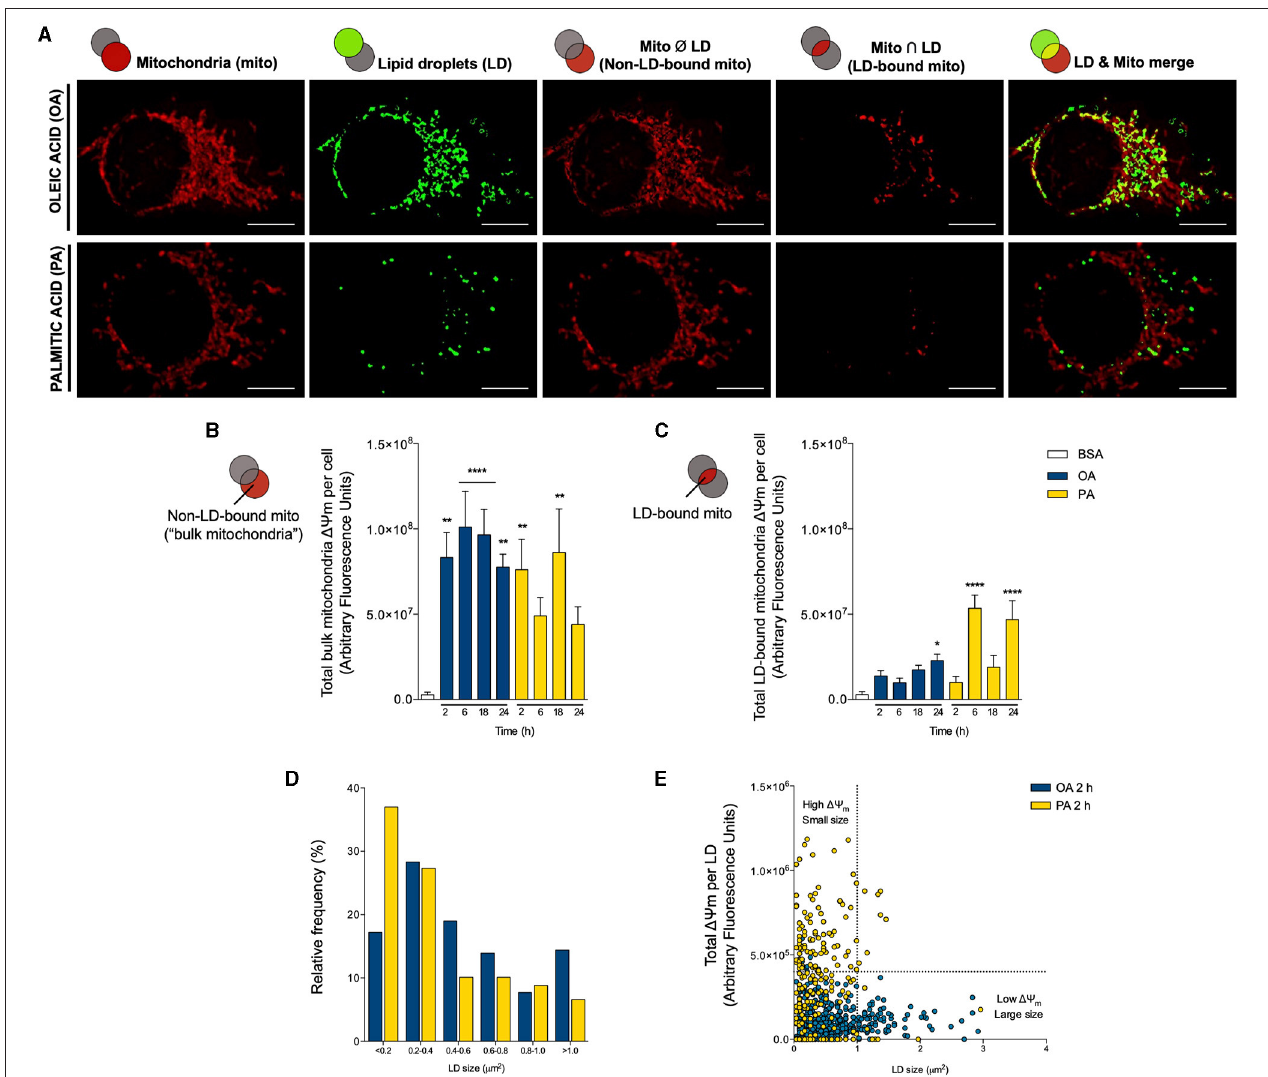
FIGURE 5 | Oleic and palmitic acids evoke different patterns of lipid droplet-mitochondria physical and bioenergetic coupling in HepG2 cells. (A) Representative confocal images of HepG2 cells treated with 200 µ M of oleic acid (OA) or palmitic acid (PA) during 6h and stained with Bodipy 493/503 (green) and MitoTracker Orange (red) for lipid droplet (LD) and mitochondria visualization, respectively. Individual organelles are shown in the first two columns, from left to right. The third column shows the intersection between LD and the mitochondrial network; that is, LD-mitochondria interaction. The fourth column shows the mitochondrial network minus the LD system; that is, non-LD-bound mitochondria or “bulk mitochondria”. The fifth column displays the merge between the first two rows. (B,C) Total 1 ψ m of “bulk mitochondria” and LD-bound mitochondria of HepG2 cells treated as in A for 0–24h, measured using MitoTracker Orange and confocal fluorescence microscopy. Data are from N = 6–20 cells analyzed from three independent experiments. Scale bar: 10 µ m. Results are shown as mean ± SEM; * p < 0.05; ** p < 0.01; and **** p < 0.0001 vs. BSA. (D) Histogram of LD size distribution of cells treated as in A for 2h. (E) Dot plot of the size of each LD vs. the 1 ψ m of associated mitochondria in cells treated as in A for 2h. The vertical dotted line cuts off small LD (left) from larger ones (right), while the horizontal line divides LDs between those associated with lower (bottom) and high (top)- 1 ψ m mitochondria.